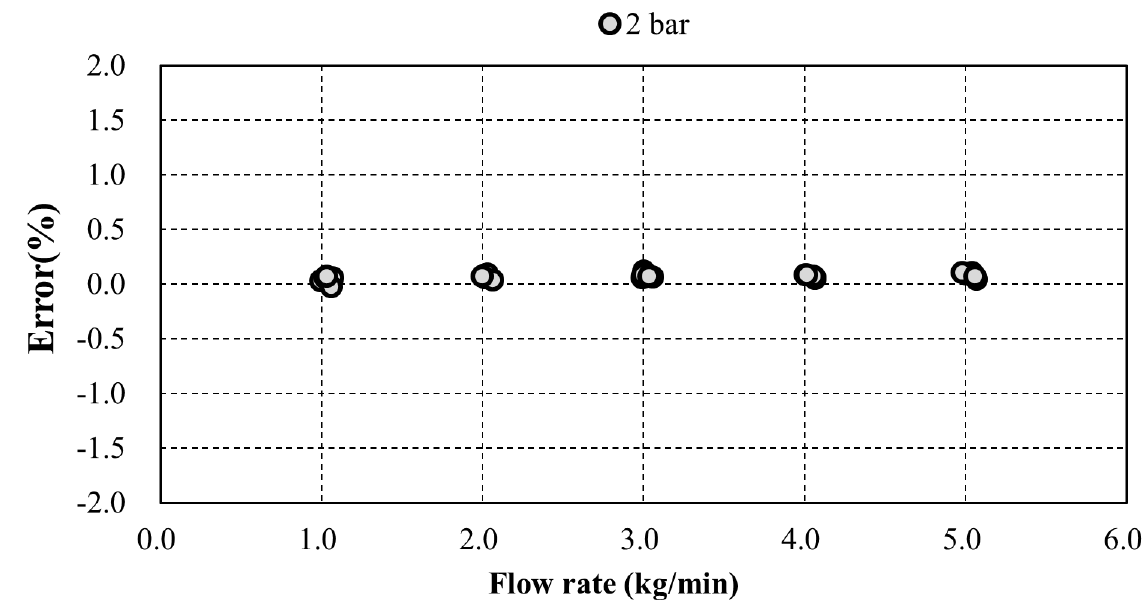
Figure 8. Measurement results of the Coriolis mass flowmeter at the inlet pressure condition of 2 bar for the pressure-matching approach.